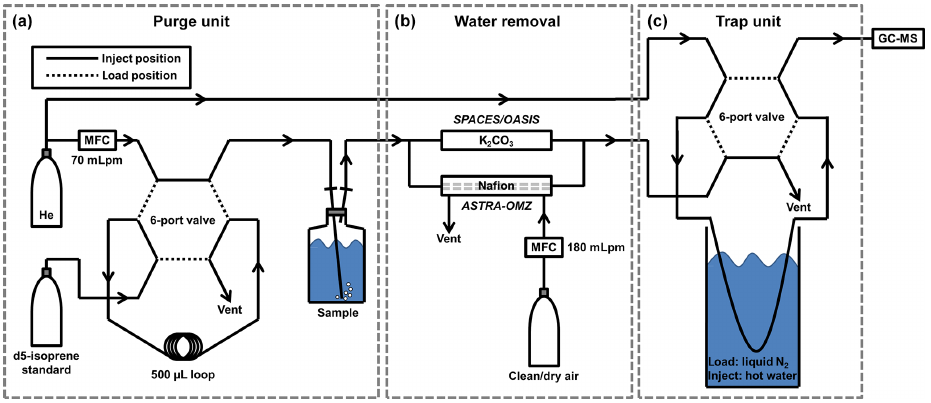
Figure 2. Schematic overview of the analytical purge-and-trap system, divided into three parts: purge unit (a) , water removal (b) , and trap unit (c) . He: helium; MFC: mass flow controller; K 2 CO 3 : potassium carbonate; GC-MS: gas chromatograph–mass